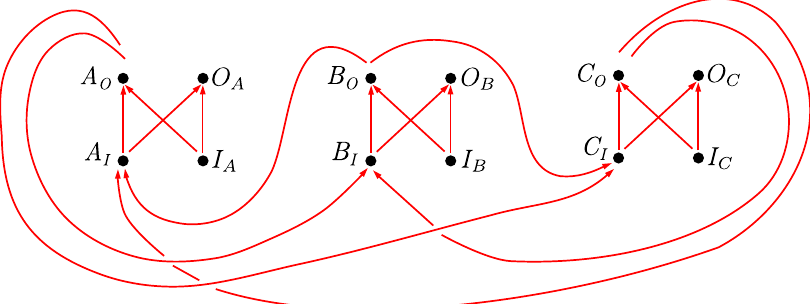
Fig. 6 | Causal structure of the cyclic causal model corresponding to the pro- cess W AF . The causal in fl uences represented by the arrows can be rigorously de fi ned in the framework of cyclic split-node causal models 40 (or, in the case of moregeneralquantumprocesses,cyclicquantumcausalmodels 40 ).Inparticular,if we regard each single variable as a split-node (or in the more general case of quantum processes, a quantum node wherethe output Hilbertspace is the dualof the input Hilbert space), the experiment can be viewed as a process on a larger numberofnodes,whichisgivenbythe(tensor)productoftheoriginalprocessand the local operations of the parties. The causal relations between the new nodes form the cycliccausalstructurein Fig. 6. This follows from the knowncyclic causal structureoftheprocess W AF 40 andthemostgeneralcausalstructurethateachlocal operation from X I , I X to X O , O X , X = A , B , C , can have. (Here, we are imagining